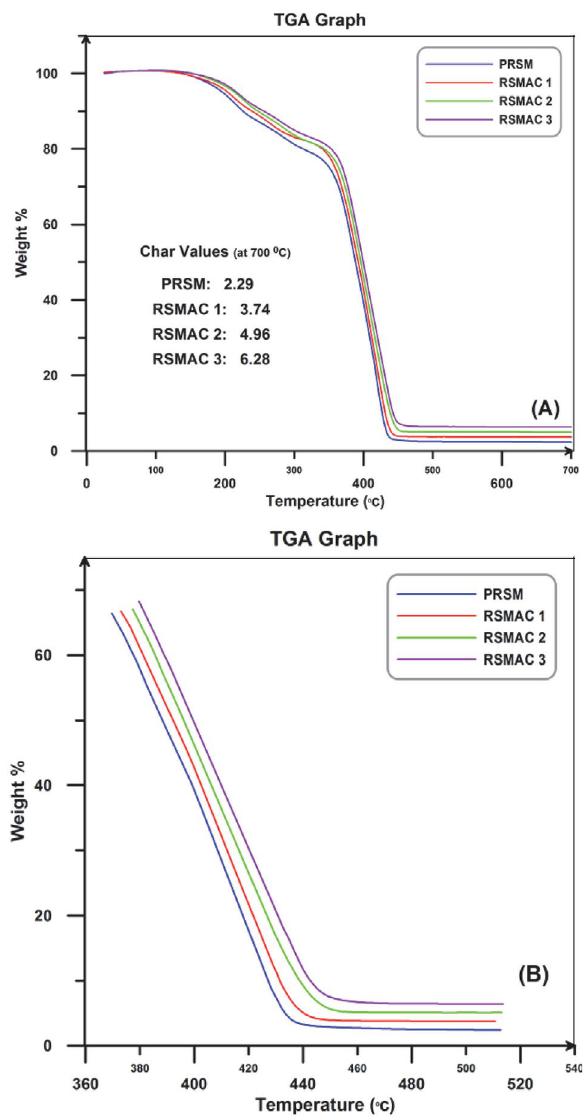
Figure 10. TGA thermograms of the PRSM and RSMAC 1-3